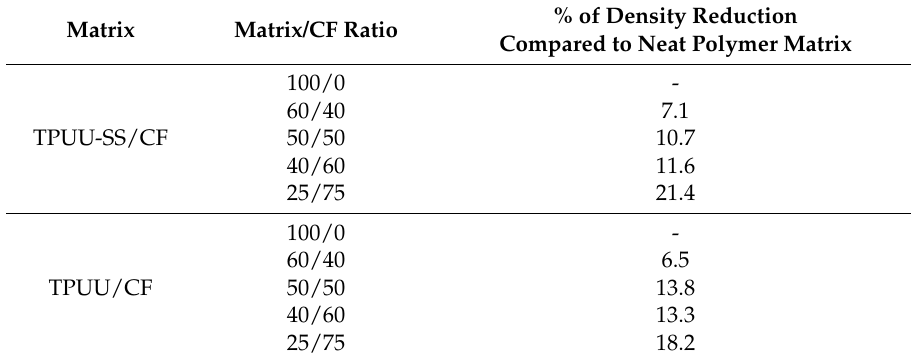
Figure 3. Density of the TPUU-SS/CF (black), TPUU/CF (gray) biocomposites and CF (0/100) as reference. Table 1. Percentage of density reduction of the biocomposites.